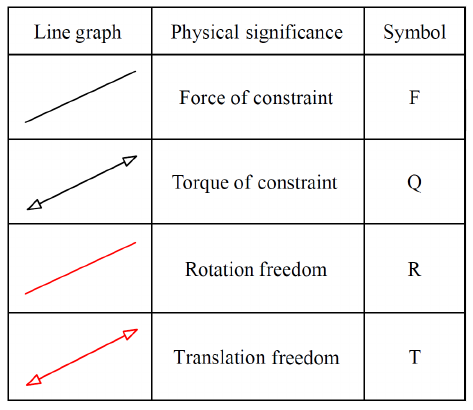
Table 1. Freedom and constraint